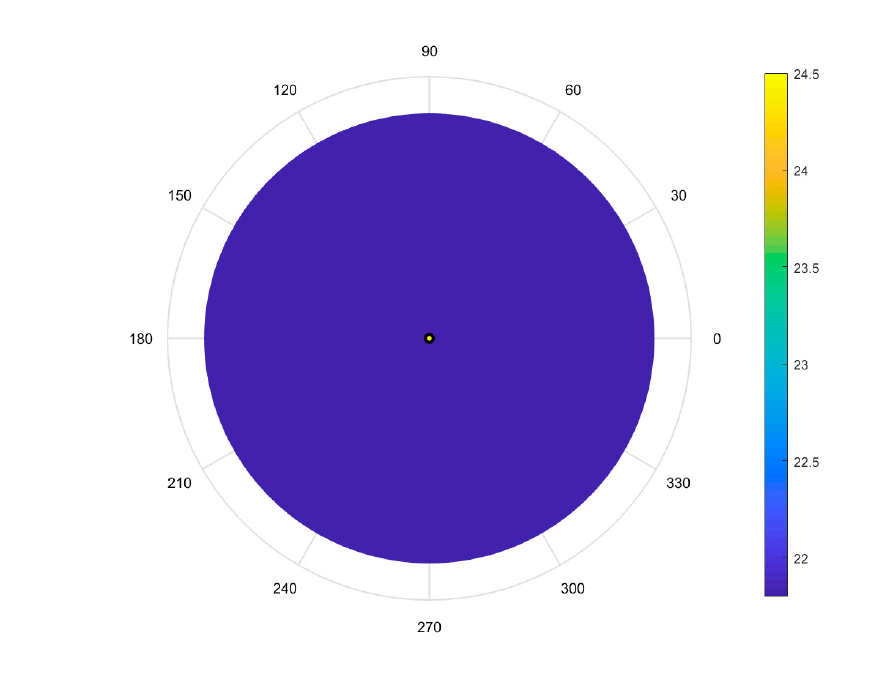
t = 0.258 s, Δ T = 2.6 ℃ (2D plot of simulations) ( a ): The ∆ T images of the CFRP specimen after the impact with a steel ball (experiments vs. simulations).